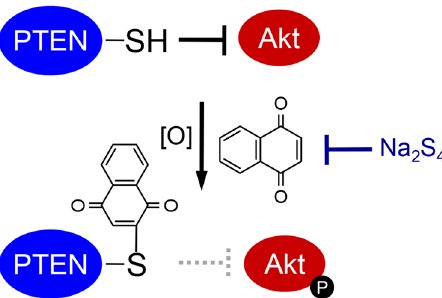
Figure 6. 1,4-NQ-mediated activation of PTEN–Akt signaling, which was suppressed by Na 2 S 4